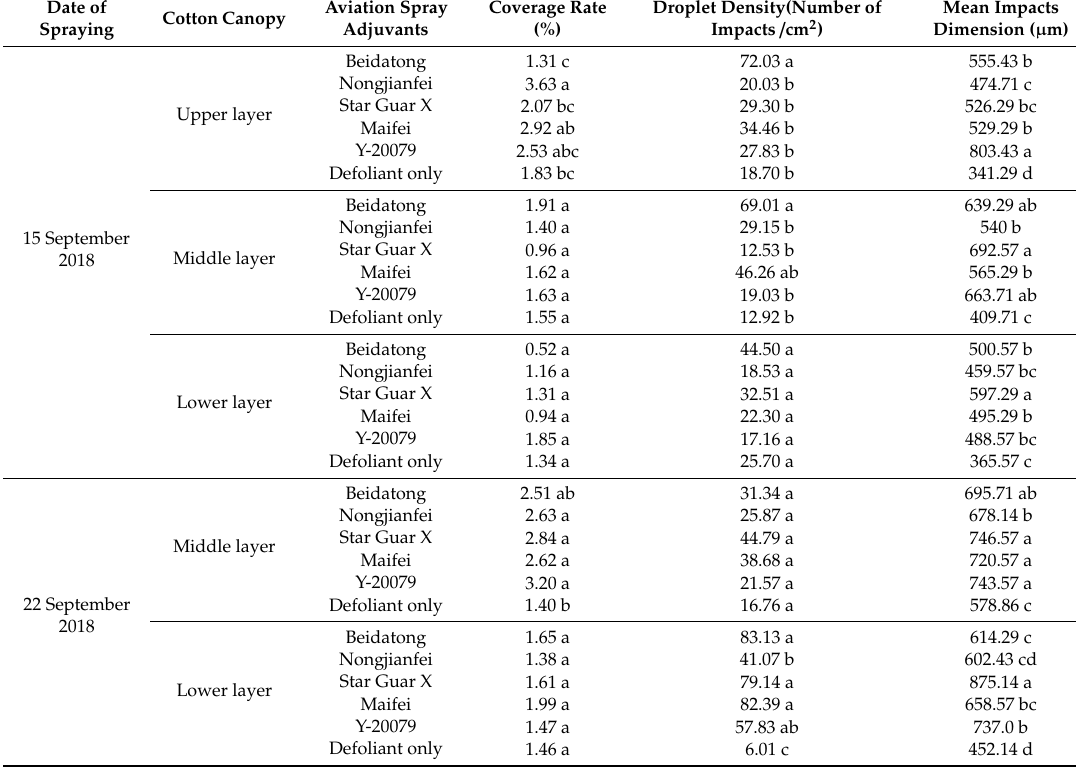
Table 4. Coverage rate, number and mean dimension of impacts in the cotton canopy (aviation spray